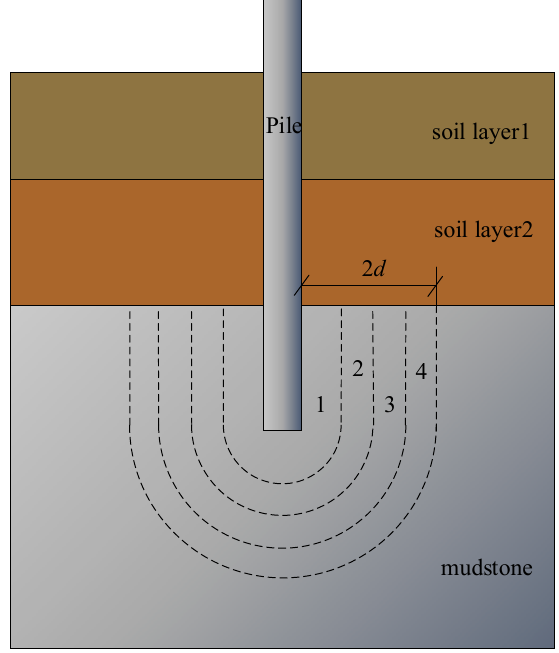
Figure 8. Diagram of numerical simulation modeling.